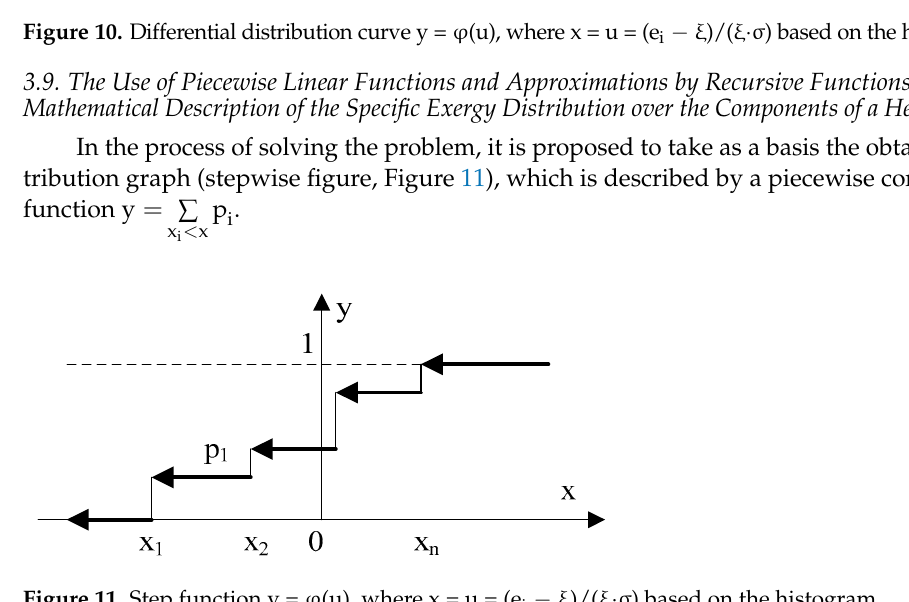
Figure 11. Step function у = φ (u), where х = u = (e i – ξ )/( ξ · σ ) based on the histogram.